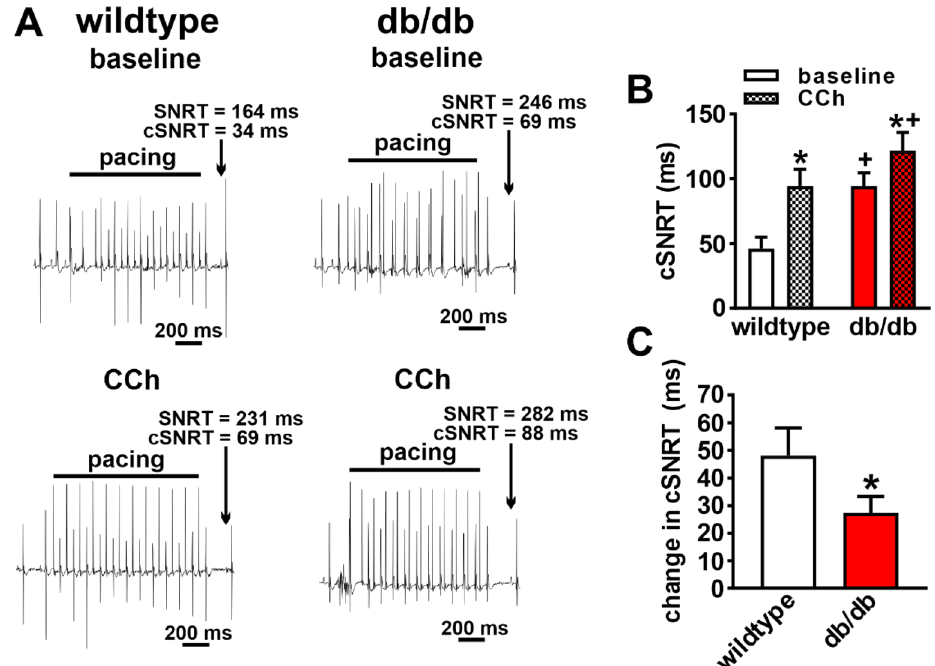
Figure 2. Effects of carbachol on sinoatrial node recovery time in db/db mice in vivo. ( A ) Representative recordings illustrating assessment of corrected sinoatrial node recovery time (cSNRT) at baseline and after CCh (0.1 mg/kg) in wildtype and db/db mice. ( B ) Summary of cSNRT at baseline and after CCh in wildtype ( n = 7) and db/db ( n = 11) mice. * P < 0.05 vs baseline; + P < 0.05 vs. wildtype by two-way ANOVA with Holm–Sidak posthoc test. ( C ) Change in cSNRT after CCh application in wildtype and db/db mice. * P < 0.05 vs. wildtype by Student’s t